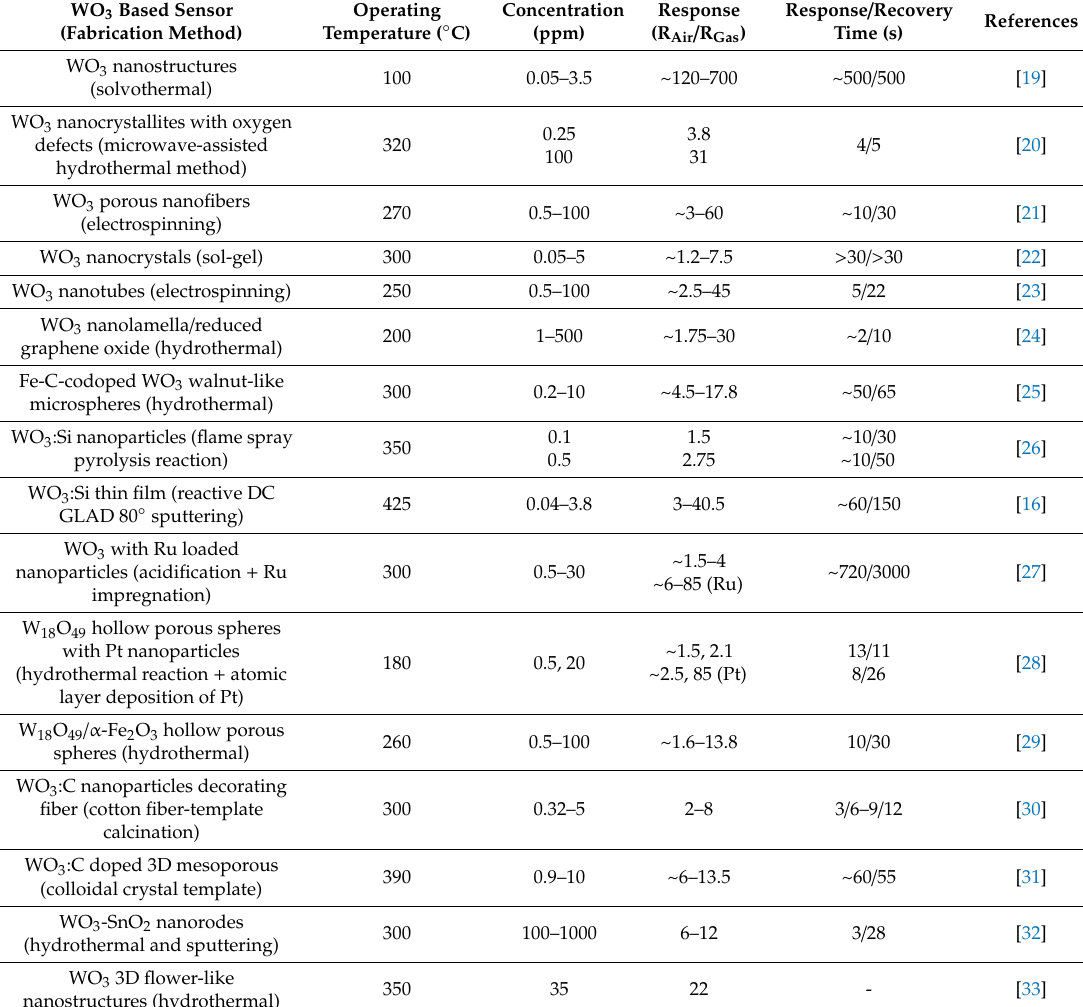
Table 1. Tungsten oxide gas sensing capability for acetone